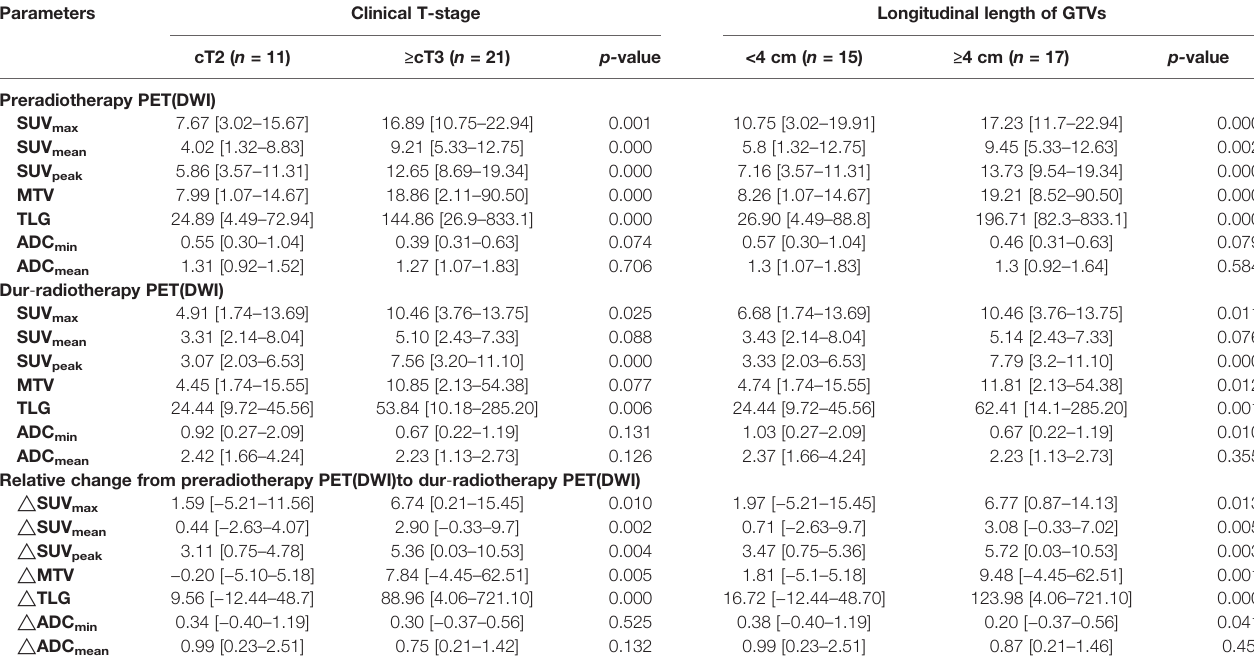
TABLE 4 | Associations of SUVs and ADCs with clinical T-stage and longitudinal length of GTVs. Parameters Clinical T-stage Longitudinal length of